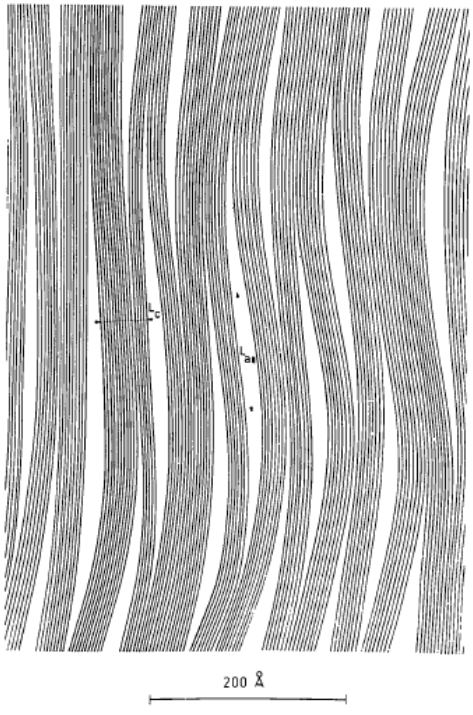
Figure 2. Microstructure of PAN carbon fibers [13] (Reproduced with permission